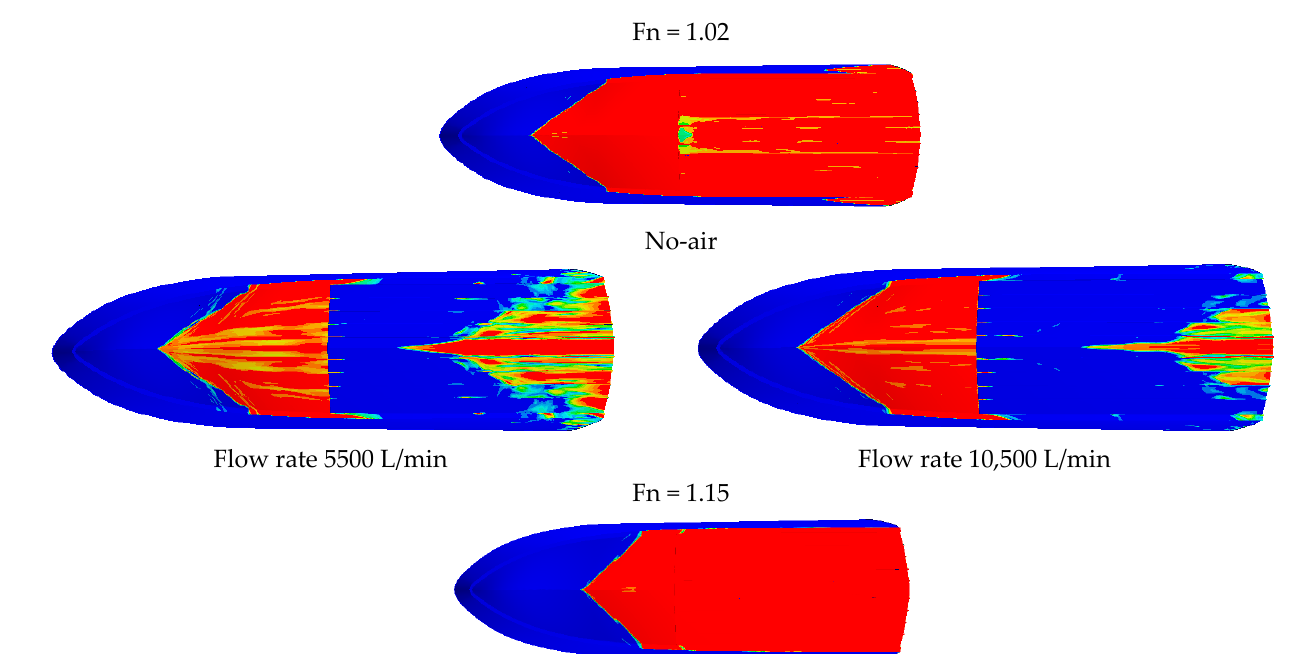
Flow rate 10,500 L/min